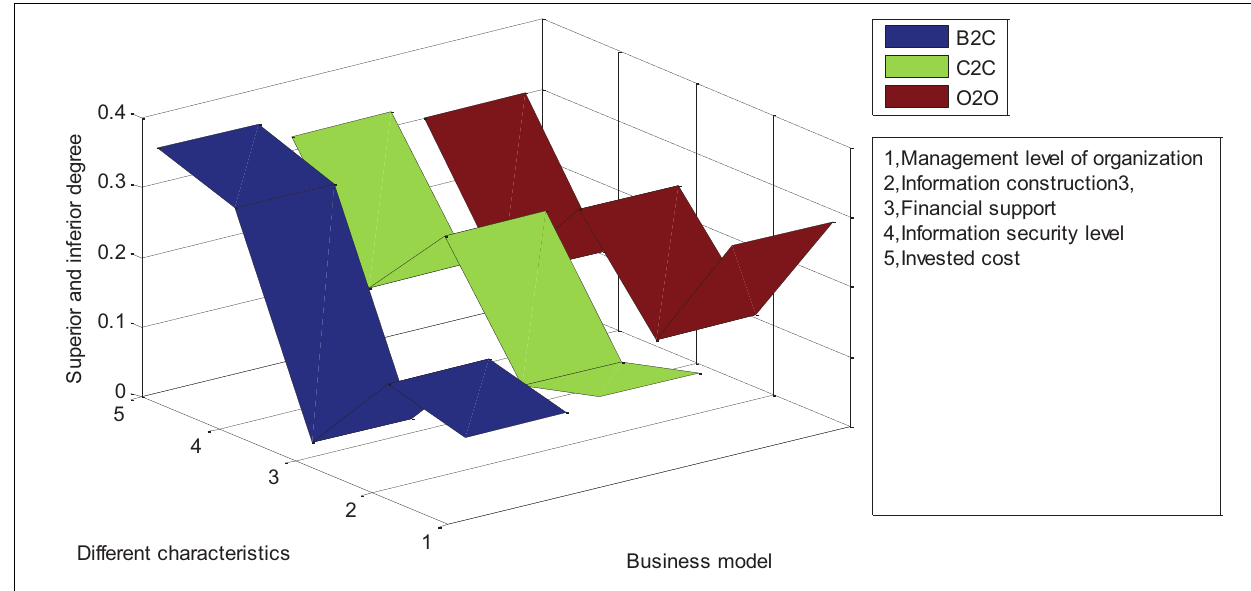
FIGURE 7 | Advantages and disadvantages of different e-commerce in industrial